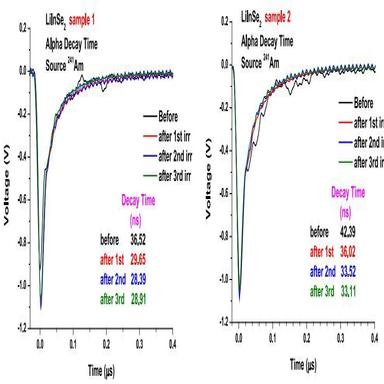
Alpha radiation decay time measured of the two samples before and after each irradiation.